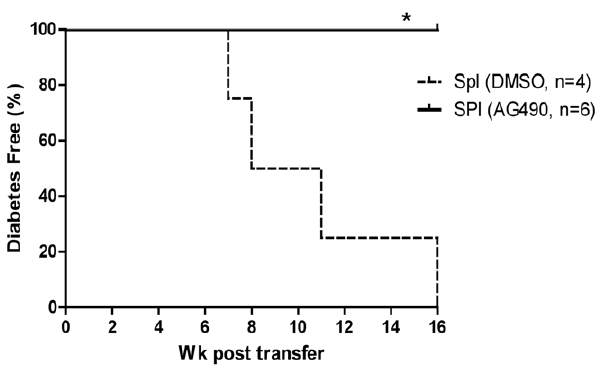
Figure 3. Invivo AG490 treated splenocytes did not transfer diabetes to NOD. Scid mice. Prediabetic NOD mice (4- weeks of age) were treated with AG490 or DMSO for five consecutive week (n=5 per group), three times per week and mice were sacrificed one week after the last injection at week 10. Splenocyte cell suspension of pooled mice immediately prepared and dead cells and red blood cells were removed by Histopacque gradient separation method and freshly isolated splenocytes containing . 99% viable cells were transferred (5 6 10 6 , i.p) into NOD. Scid mice. Blood glucose in recipient mice was monitored at least once a week as described earlier (*: p=0.02, Kaplan-Meier